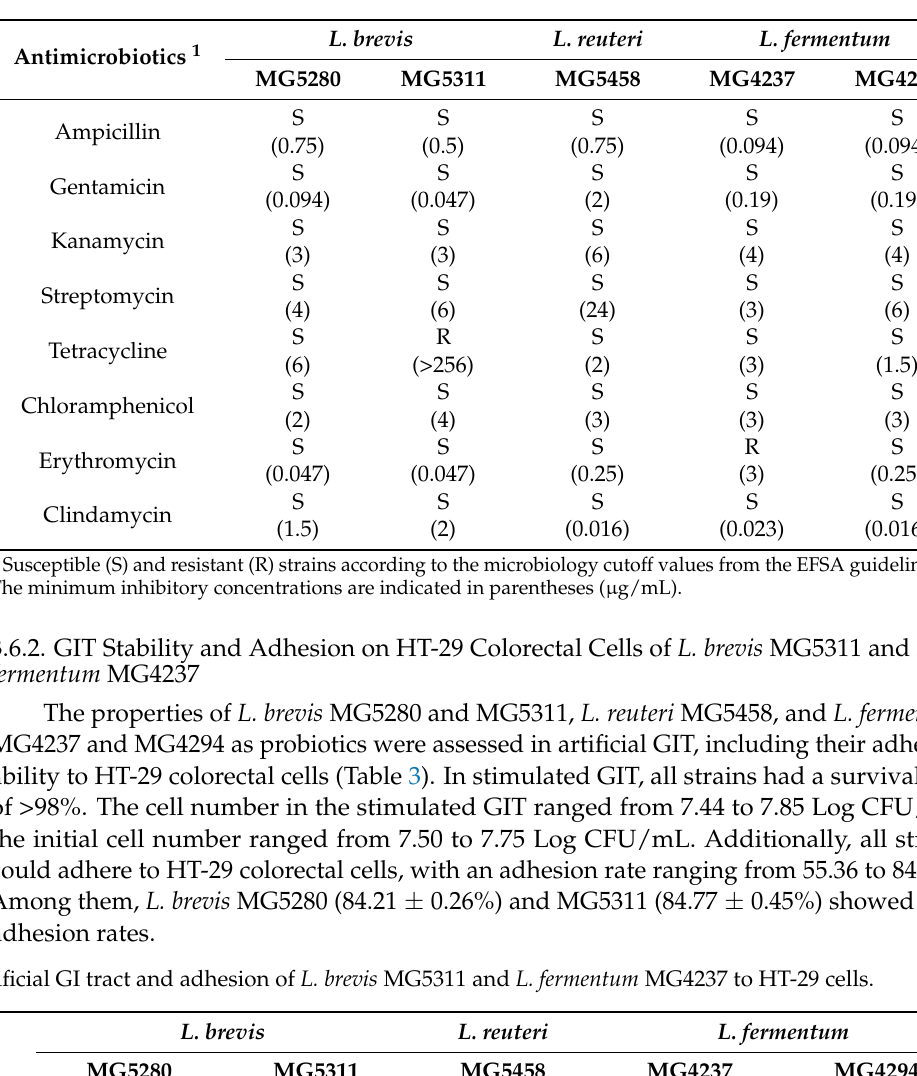
Table 2. Results of antimicrobial test with the LAB strains.